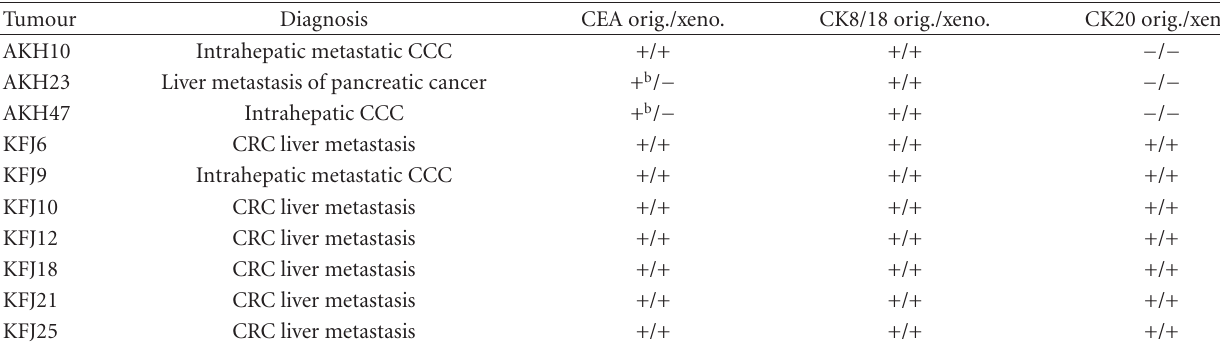
Table 3: Immunohistochemical analyses of human original and corresponding xenograft tumours. CCC: cholangiocellular carcinoma; CRC: colorectal carcinoma; n.a.: not analysed; − : no staining; +: positive staining; b single stained cells or staining restricted to normal liver cells; orig.: original tumour sample; xeno.: xenograft tumour sample. Tumour Diagnosis CEA orig./xeno. CK8/18 orig./xeno. CK20 orig./xeno.